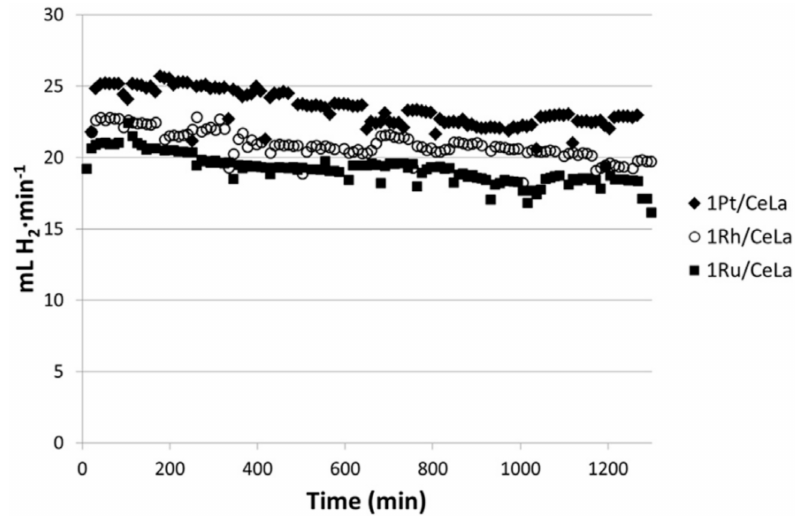
Figure 8. H 2 production at 700 ◦ C over time on stream, F OMW = 0.6 mL · min − 1 , GHSV = 9000 h − 1 . Reprinted with permission from Ref. [28]. Copyright 2021 Elsevier.